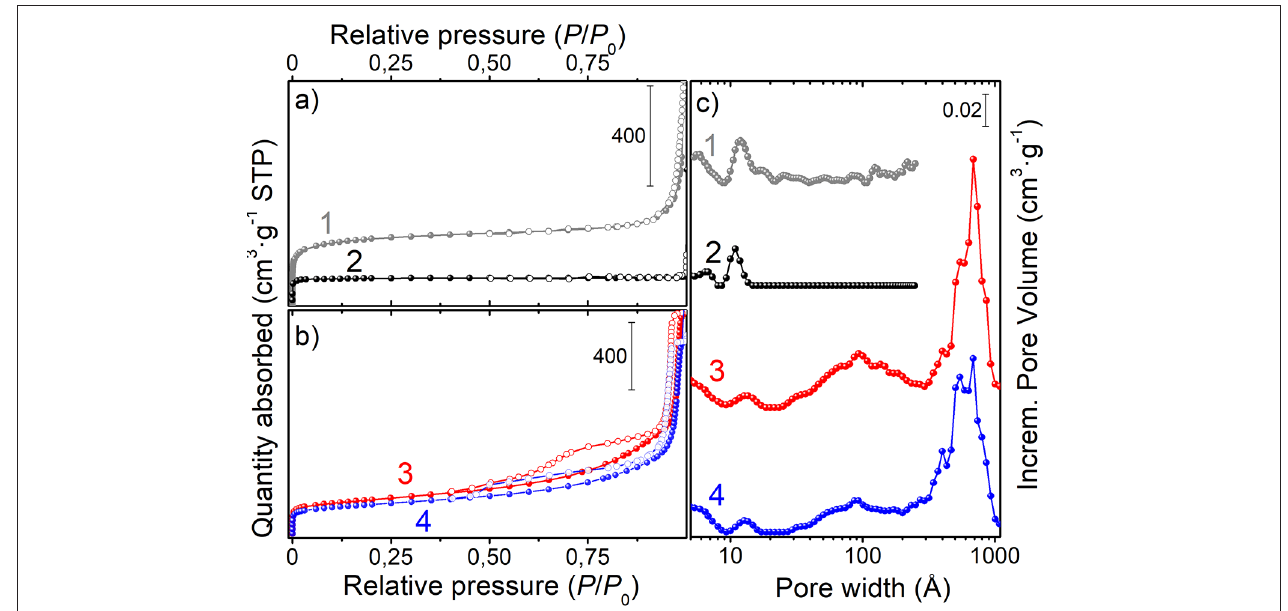
FIGURE 4 | N 2 -adsorption/desorption isotherms of: (a) the native PS-co-DVB (1-curve) and of the same polymer spheres pyrolyzed at 800 ◦ C for 5h (2-curve); (b) ZnCl 2 /PS-co-DVB composite spheres treated at 800 ◦ C for 5h (3-curve) and ZnCl 2 carbon microspheres after the subsequent impregnation with Fe(NO 3 ) 3 and thermal treatment at 800 ◦ C for 5h (4-curve); (c) pore size distributions of the samples.